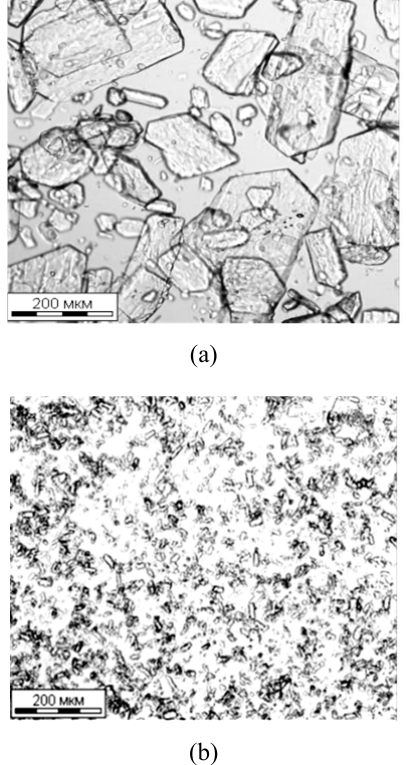
Fig. 3. Micrographs of glucose crystals: (a) the initial seed crystals of hydrate glucose wet with propanol; (b) the same crystals 30 minutes after immersion in the